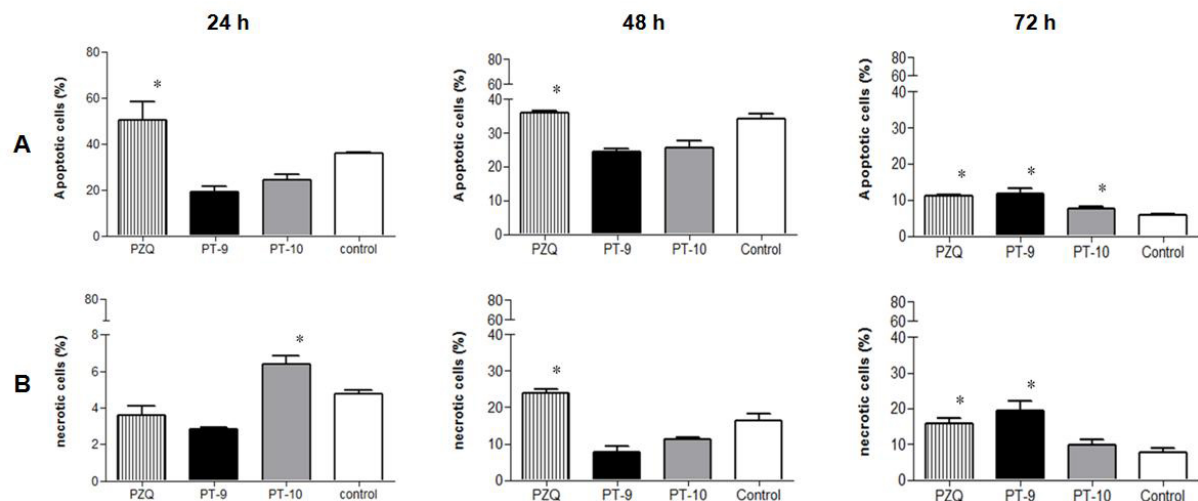
Figure 2. The effects of imidazolidine derivatives on immune spleen cell viability. ( A ) Apoptosis investigated using annexin V at 24, 48 and 72 hours assay. PZQ was statistical superior to PT-9 and PT-10 but not to controls at 24 hours. At 48 hours, PZQ was superior to LPSF/PT-9 and LPSF/PT-10, but not to controls. PZQ, LPSF/PT-9, and LPSF/PT-10 were all superior to control, and PZQ was superior to PT-10 at 72 hours. ( B ) Necrosis assay using propidium iodide at 24, 48 and 72 hours. PT-10 demonstrated a higher quantity of necrotic cells than controls, PZQ, and LPSF/PT-9 at 24 hours. PZQ was superior to LPSF/PT-9 and LPSF/ PT-10 and controls at 48 hours. PZQ and LPSF/PT-9 were superior to controls and LPSF/PT-10 at 72 hours. Horizontal bars represent the average of three independent experiments per group. * p <